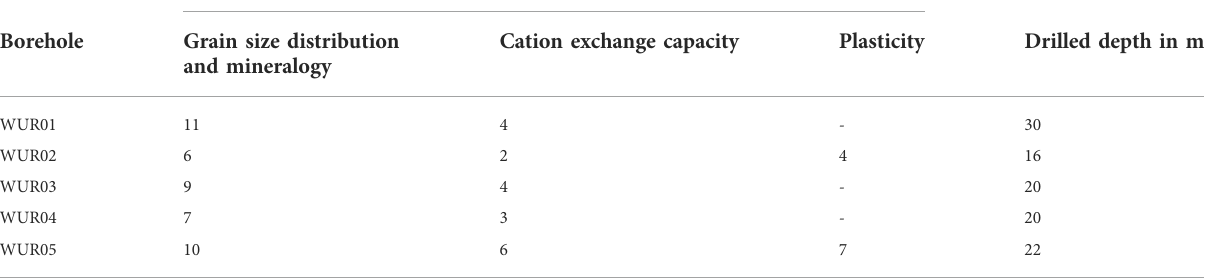
TABLE 4 Drilled depth, performed laboratory investigations and associated number of samples in each borehole. The mineralogical investigations included both bulk rock and clay mineralogy.